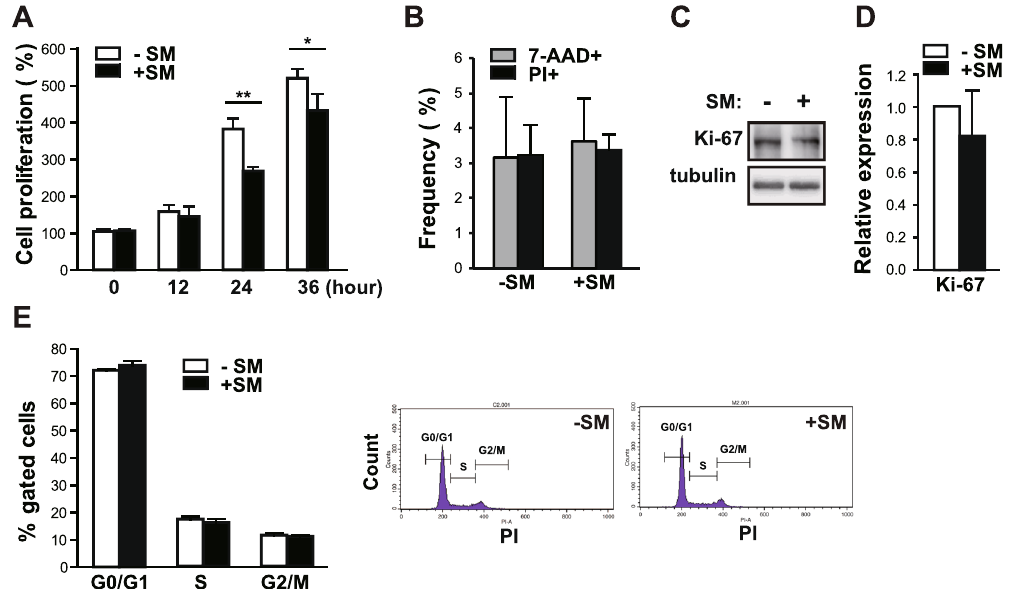
Figure 1. SM inhibits the growth of human eSCs without any changes in cell death and cell cycle progression. ( A ) Primary human eSCs were incubated either under terrestrial gravity (1 g ) or under SM for indicated time periods and counted using a cell counter. ( B ) The cells were treated as ( A ) for 36 h, stained with either 7-AAD or PI, and then analyzed by flow cytometry. ( C ) The cells were treated as in ( B ), lysed, and analyzed by western blotting. ( D ) Western blot images were analyzed using ImageJ to determine the relative protein expression of Ki-67 (using tubulin as the internal control). ( E ) The cells were treated as ( B ), stained with PI and analyzed using flow cytometry. Abbreviations: simulated microgravity (SM); 7-aminoactinomycin D (7-AAD); propidium iodine (PI). Data are expressed as mean ± standard deviation (SD), with paired t -tests performed as indicated. * P < 0.05, ** P < 0.01 versus control at each indicated